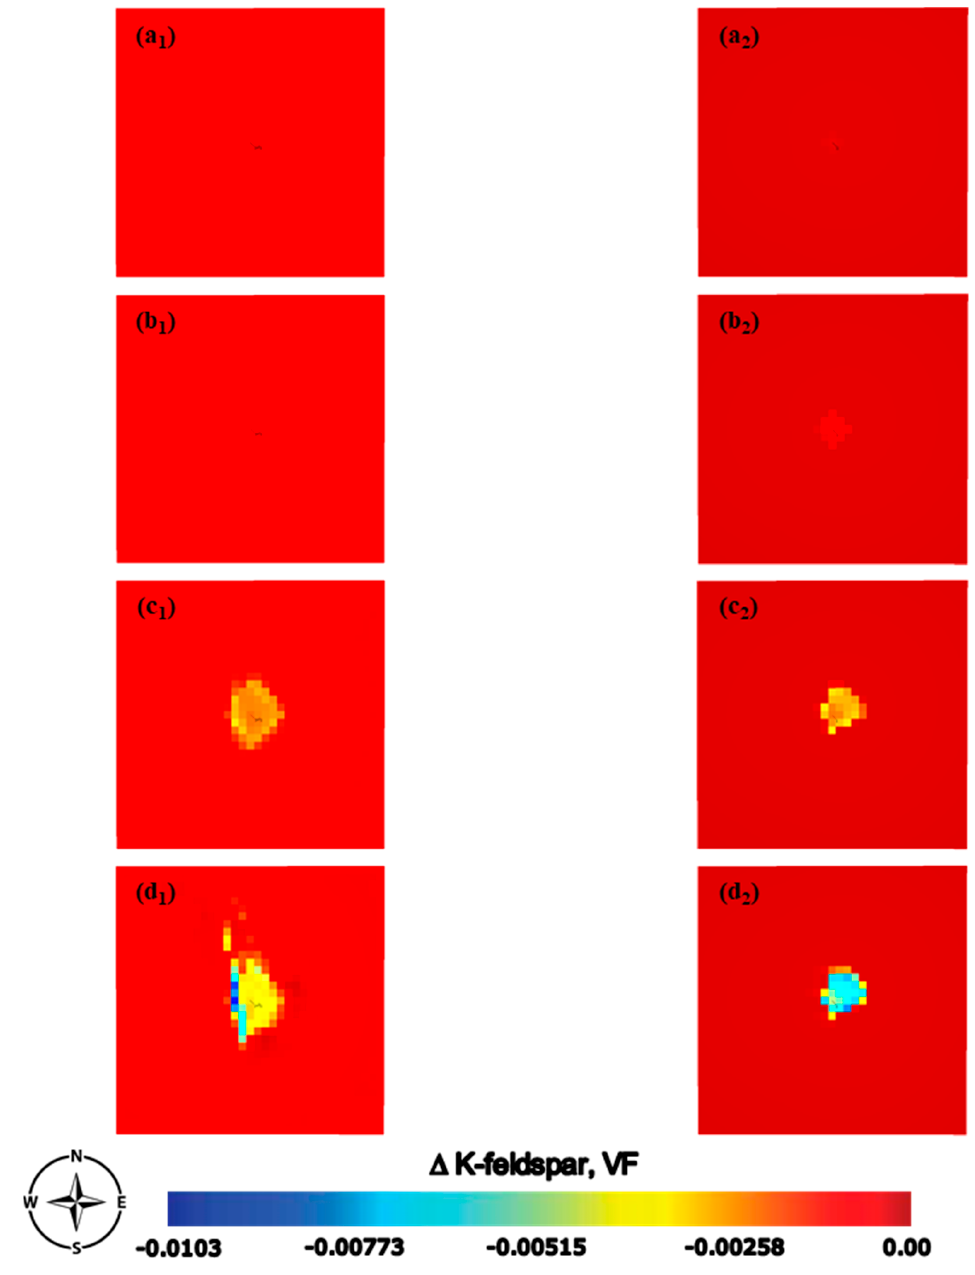
Figure 7. Plan view diagrams illustrating the simulated ∆ K-feldspar volume fraction evolution for the base case from the arkosic layer top view ( a 1 , b 1 , c 1 , d 1 ) and homogenous case from the Upper Mt. Simon top view ( a 2 , b 2 , c 2 , d 2 ) at ( a ) 30 years, ( b ) 100 years, ( c ) 1000 years, and ( d ) 10,000 years. Each figure’s size is 35 km × 35 km (x, y).